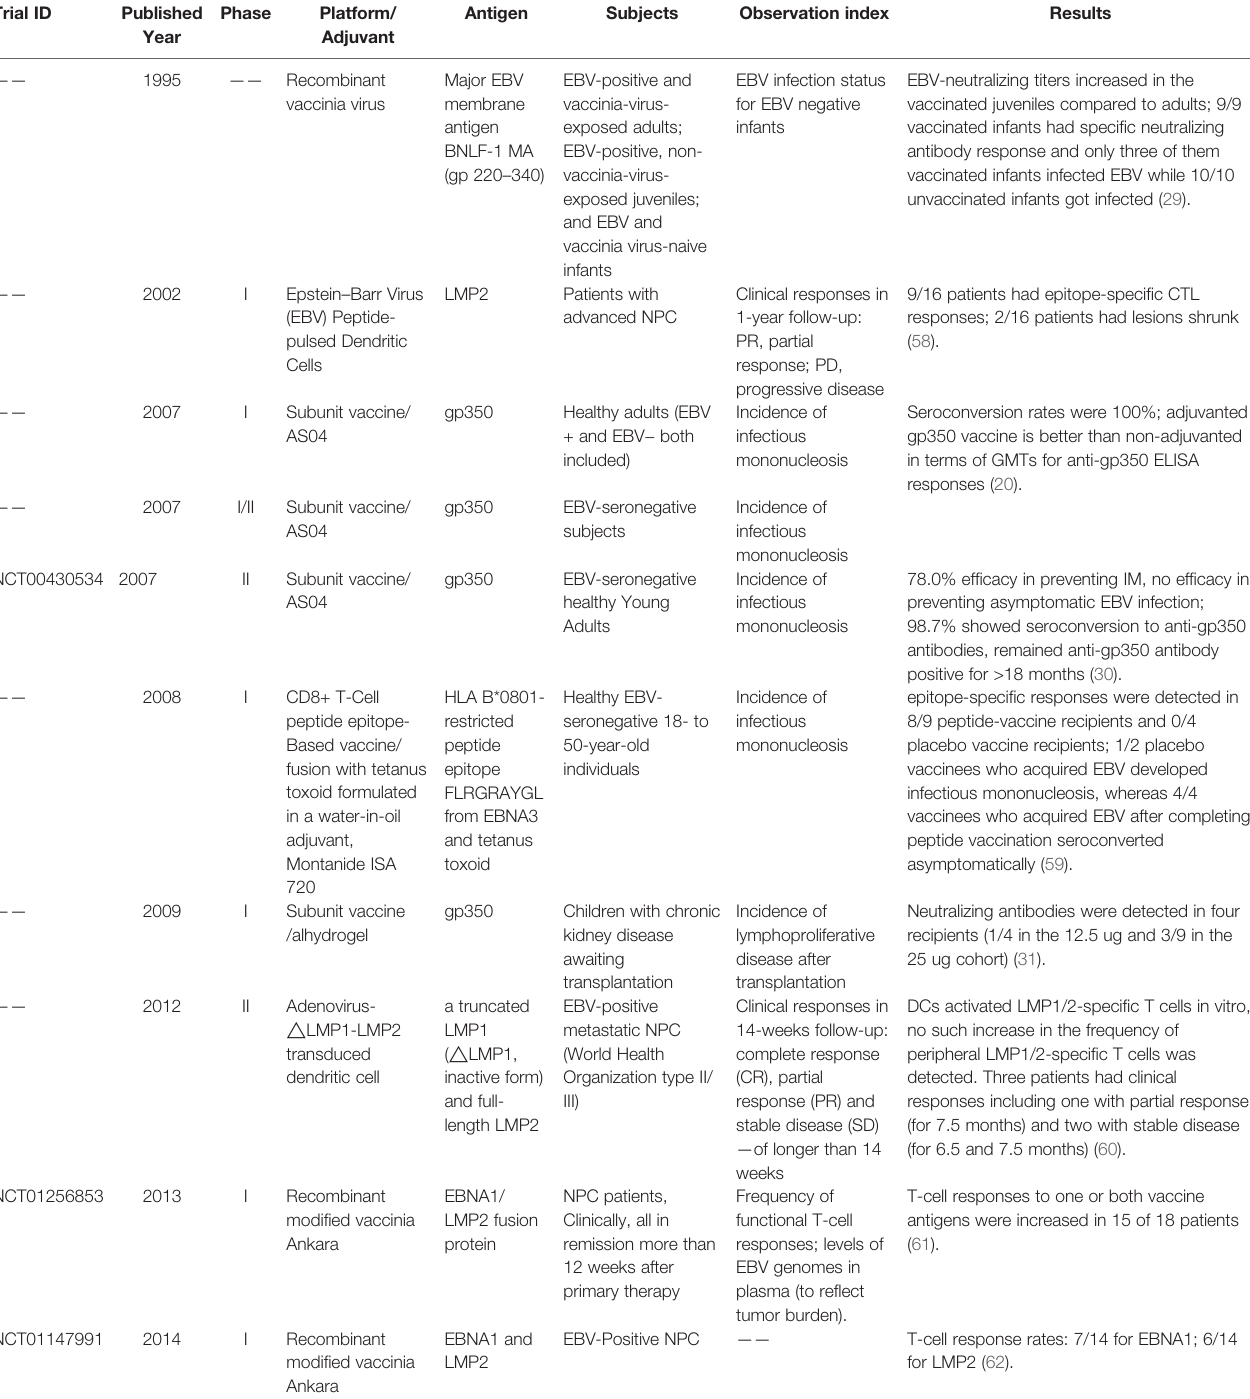
TABLE 2 | Summary of EBV vaccine clinical trials. Trial